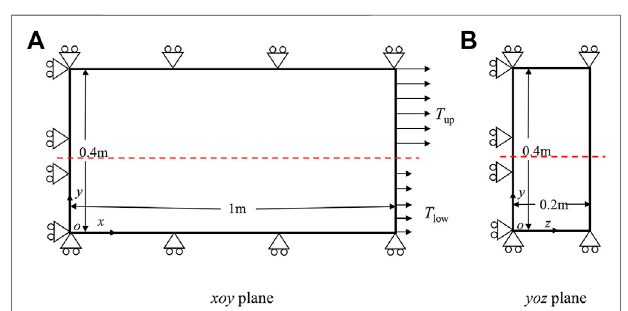
FIGURE 13 | Setup of 3-D beam problem. (A) xoy plane; (B) yoz plane.